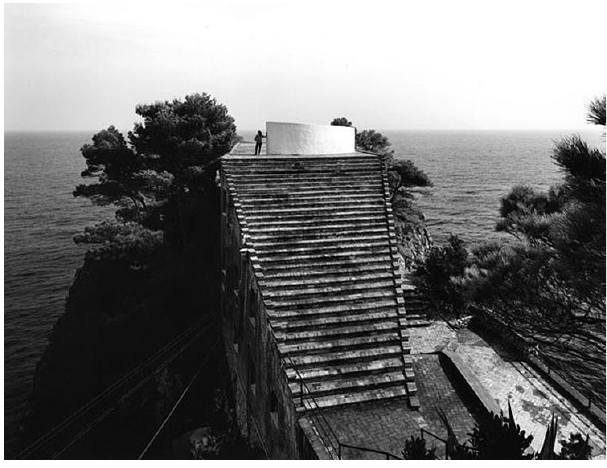
Figure 1 Adalberto Libera, Casa Curzio Malaparte, Capri, 1937-41 (Url